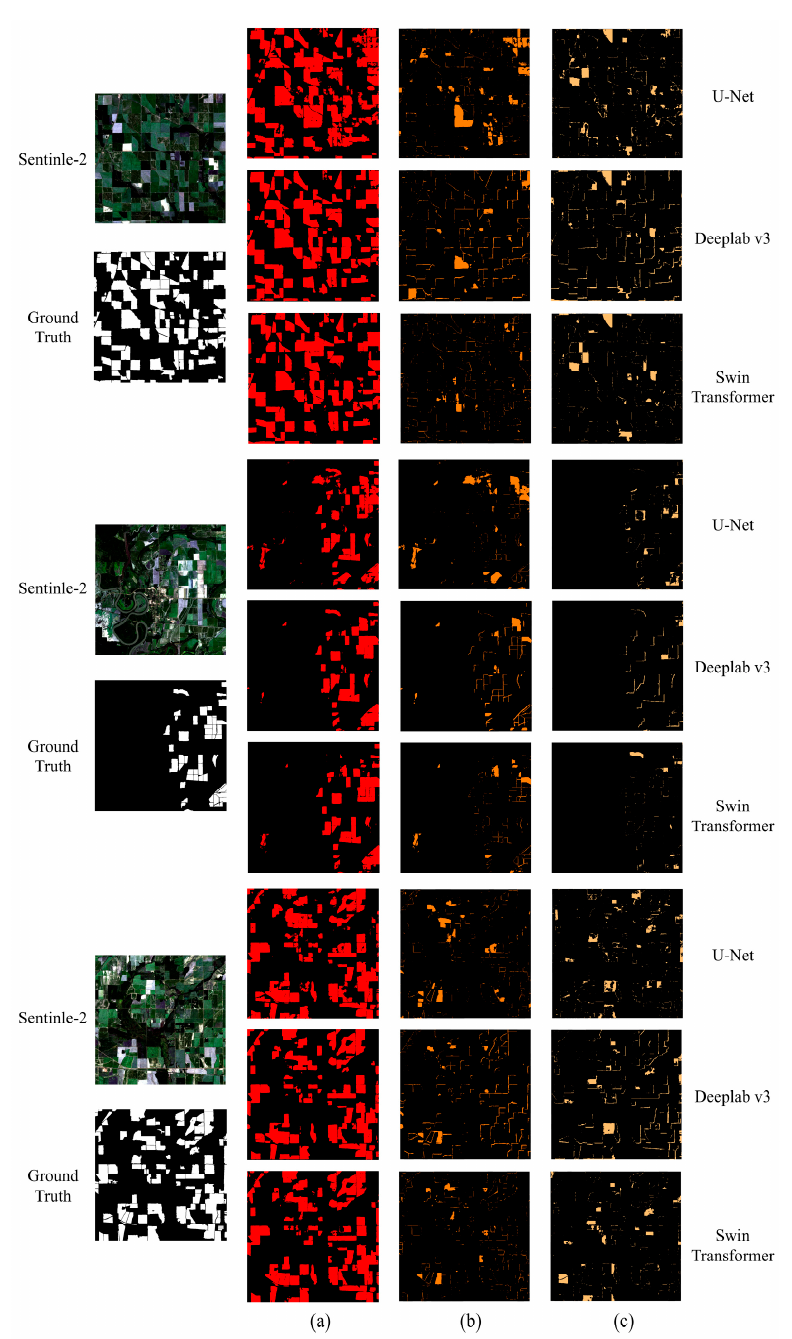
Figure 8. Rice identification prediction results. ( a ) Rice prediction map. ( b ) Non-rice wrong prediction map. ( c ) Rice warning prediction map.